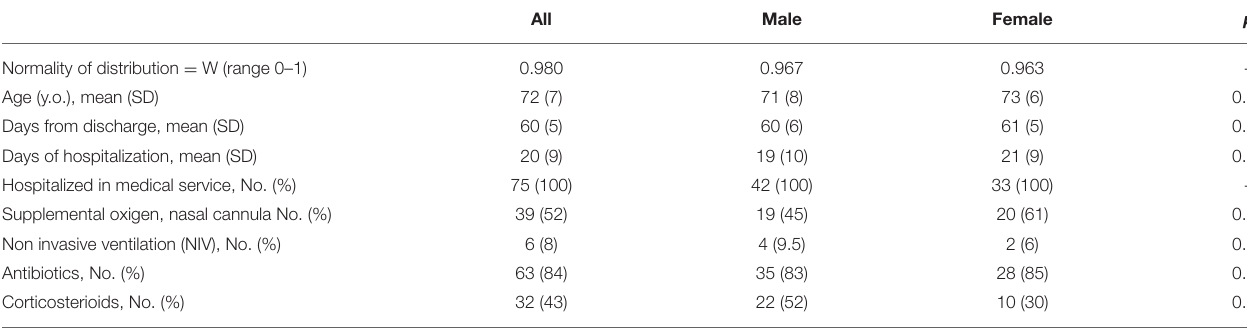
TABLE 1 | Patient’s clinical data according to gender.